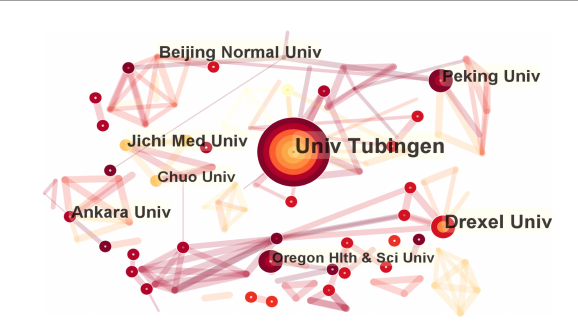
FIGURE4 Map of active institution in functional near-infrared spectroscopy (fNIRS) research on diseases.